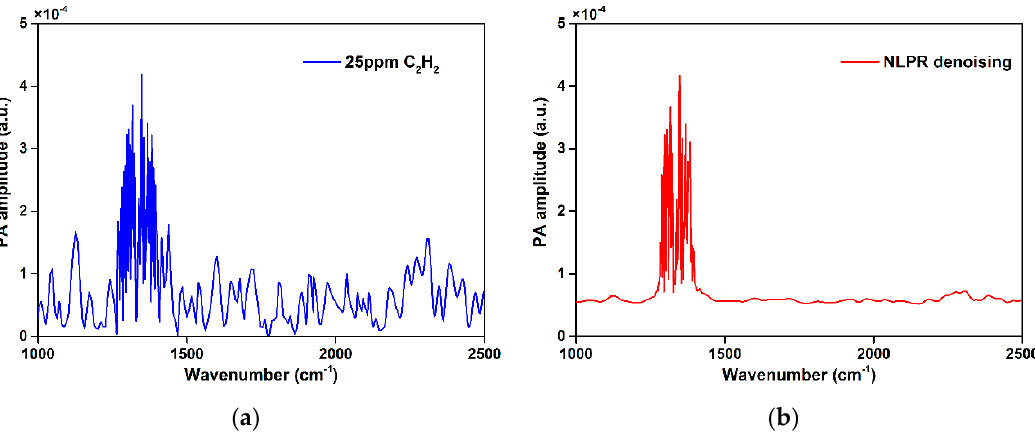
Figure 6. ( a ) The PA spectrum of 25 ppm C 2 H 2 ; ( b ) the denoised PA spectrum of 25 ppm C 2 H 2 by the NLPR algorithm.